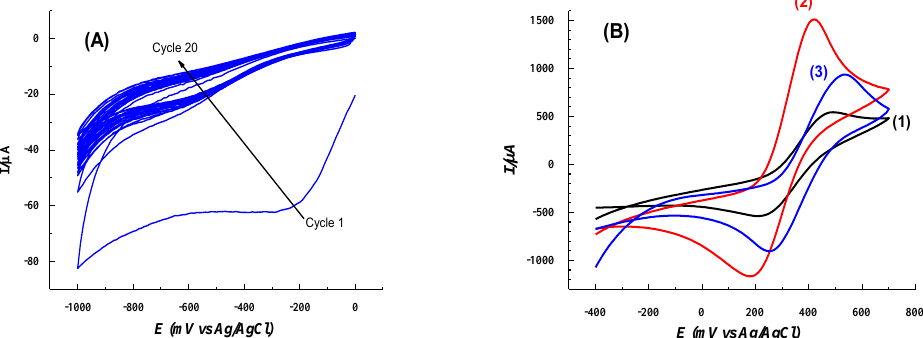
Figure 1. Cyclic voltammograms corresponding to the electrografting of 4-carboxybenzenediazonium tetrafluoroborate. ( A ) Electroreduction, ( B ) passivation test in H 2 O / KCl 0.1 M solution, containing 0.01 M of K 3 [Fe(CN) 6 ] and 0.01 M of K 4 [Fe(CN) 6 ]: (1): as-received gold electrode; (2): cleaned electrode and (3): after electrografting of the diazonium salt. Scan rate: 100 mV / s, 20 cycles for electrografting.